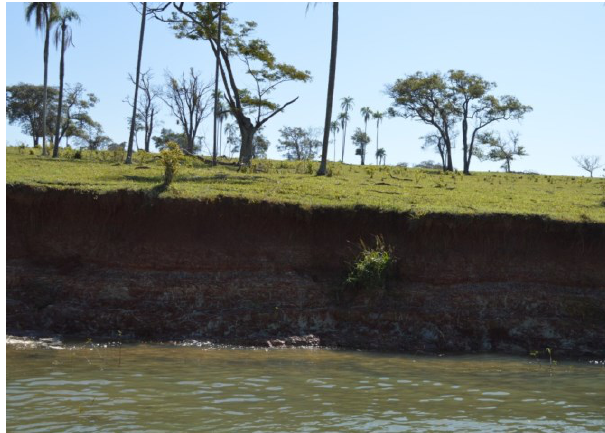
Figure 2. Example of an erosion process in the reservoirs of Chavantes, São Paulo,